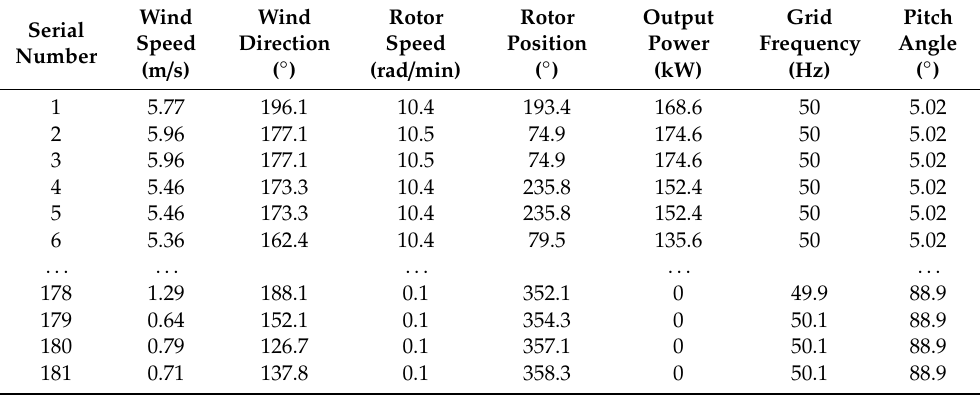
Table 10. SCADA system indicator variable data when the system is in pitch faulty